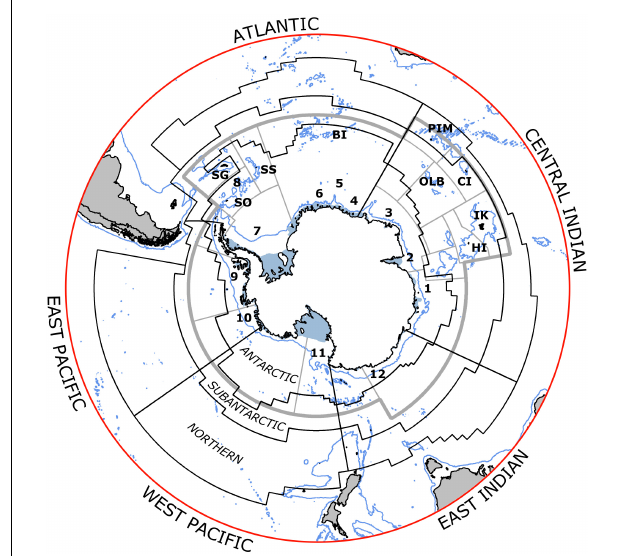
FIGURE 1 | Areas for assessing status and trends of dominant metazoan zooplankton in the Marine Ecosystem Assessment for the Southern Ocean (black lines). Sectors are divided meridionally: corresponding names of sectors are outside the circle. Zones extend from the coast to the Southern Antarctic Circumpolar Current Front (SACCF, Antarctic), to the Subantarctic Front (SAF, Subantarctic) and to the Subtropical Front (STF, Northern). Seas are marked in the Antarctic Zone as (1) Davis, (2) Cooperation, (3) Cosmonaut, (4) Riiser-Larsen, (5) Haakon VII, (6) Lazarev, (7) Weddell, (8) Scotia, (9) Bellingshausen, (10) Amundsen, (11) Ross, and (12) Dumont D’Urville. Islands in the Commission for the Conservation of Antarctic Marine Living Resources (CCAMLR) area include Heard (HI), Isles Kerguelen (IK), Crozet (CI), Prince Edward-Marion (PEM), Bouvet (BI), South Sandwich (SS), South Georgia (SG), South Orkney (SO), Ob and Lena Banks (OLB), and South Shetlands (not initialed but found on the north-western side of Antarctic Peninsula). Gray lines indicate the CCAMLR reporting areas (Subareas and Divisions). NB: The Southern Boundary (not shown) and the STF mark the southern and northern limits of the intense eastward flowing Antarctic Circumpolar Current (ACC, not shown), which reaches up to 2000 km wide and extends from surface waters to 2000–4000 m. The Antarctic Polar Front, APF (not shown) lies between the SACCF and SAF and represents an important ecological boundary. It marks the northern extent of ice-influenced surface waters, and the transition between the cold surface waters to the south and the warmer waters to the north. Within the ACC, the SACCF, APF, and SAF delimit boundaries between different water masses with distinct and relatively homogeneous physical and chemical characteristics. These also coincide with intense narrow currents jets that dominate the ACC (see Orsi et al., 1995; Rintoul, 2018; Park et al., 2019; Chapman et al.,